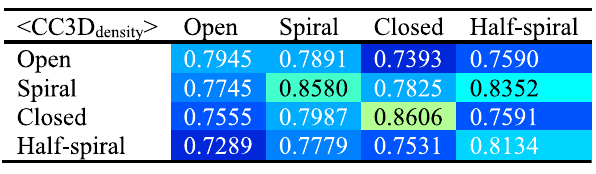
TABLE 3 | Summary of Table 2 to average cross-correlation between different types of AFM images (by averaging over each 3 × 3 block in Table 2